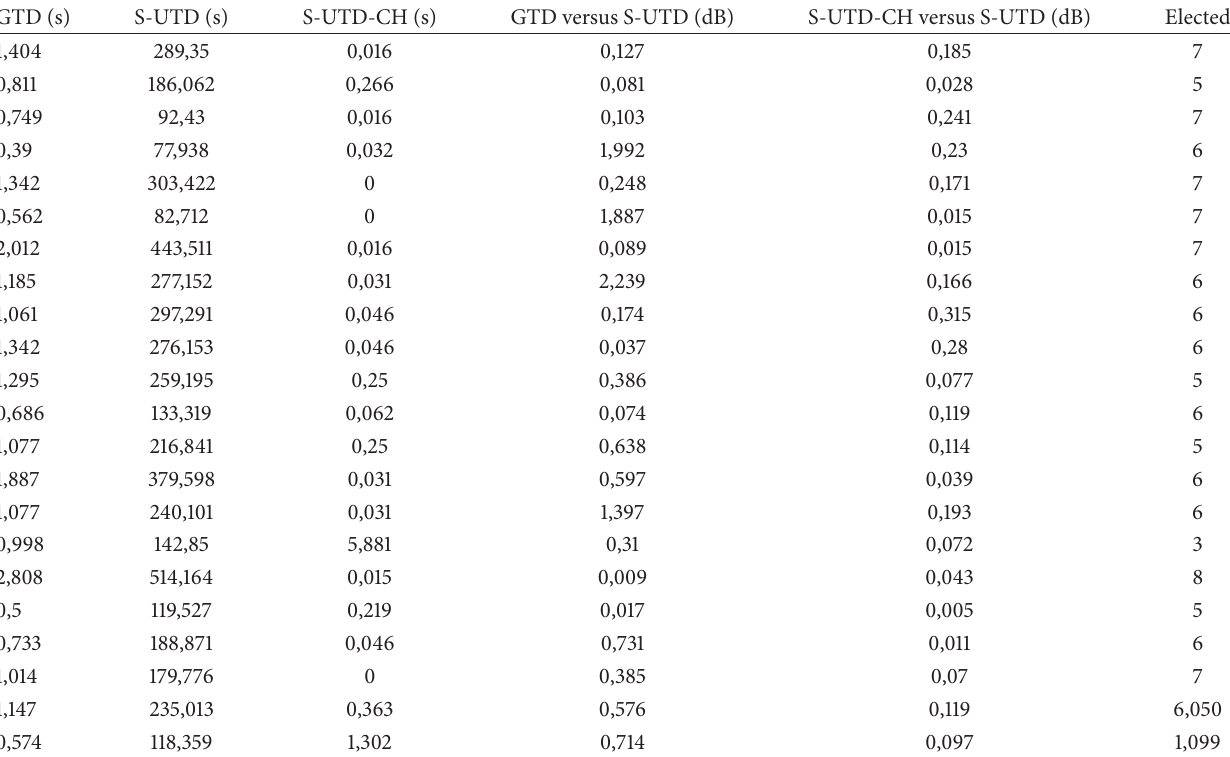
Table 3: Comparison results of the same receiver height (15m).